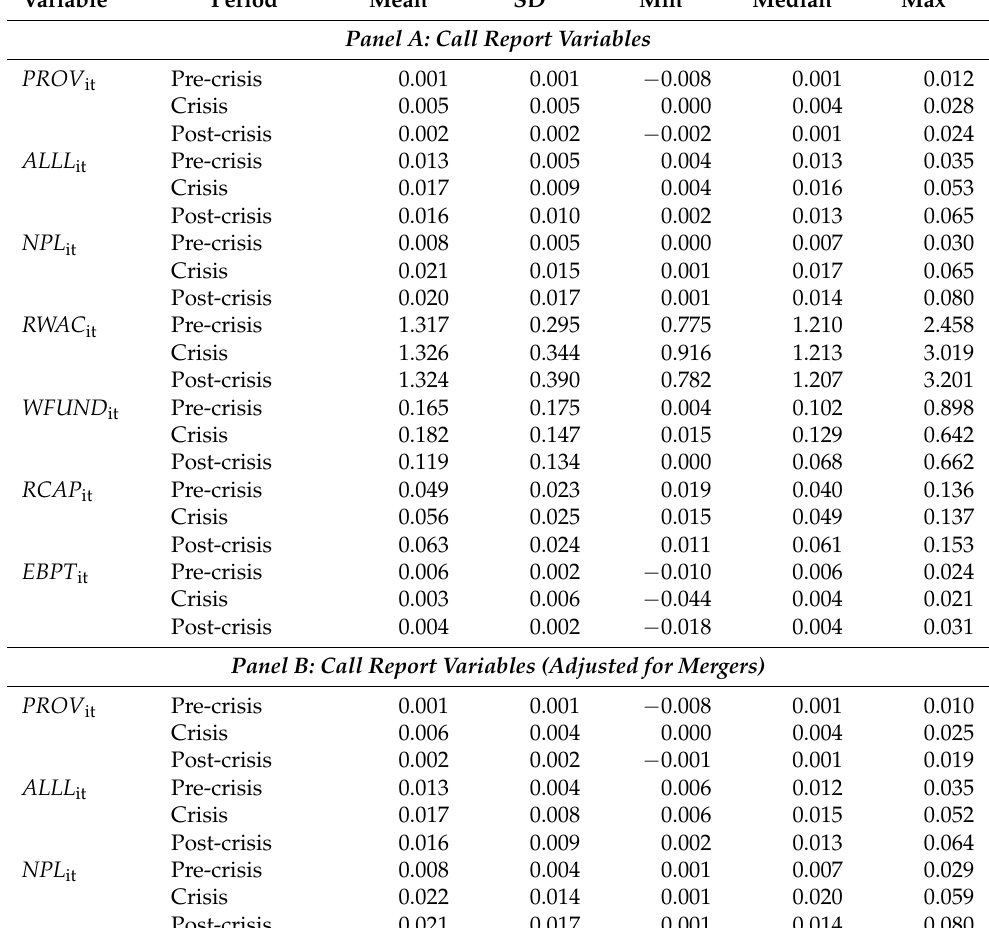
Table 4. Summary